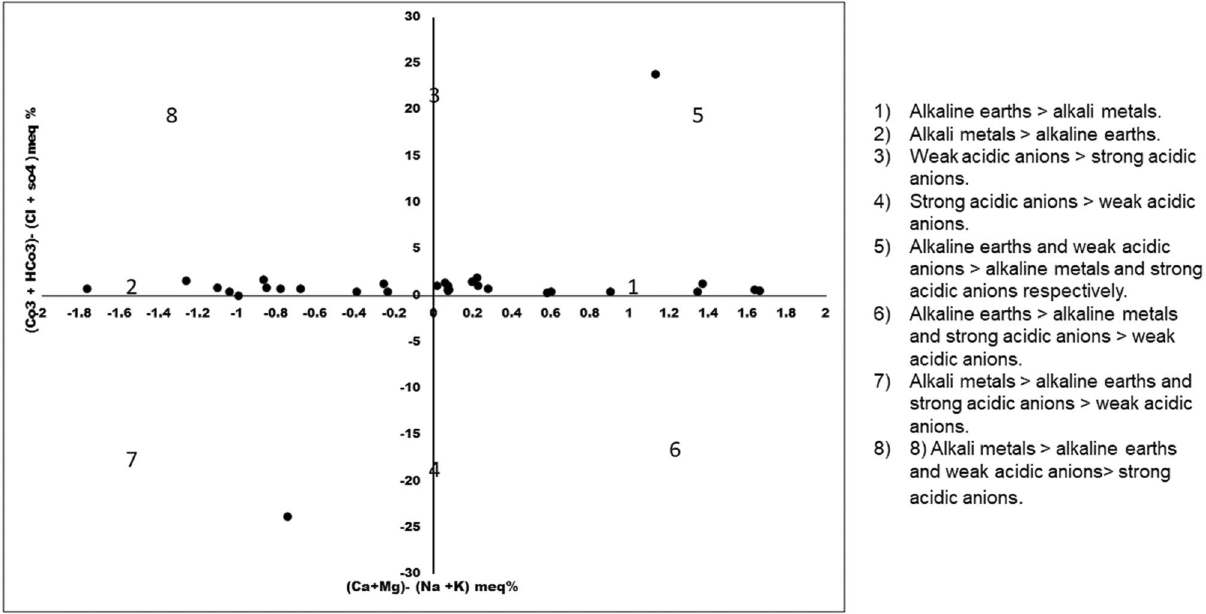
Figure 10. Chadha’s Plot for hydrogeochemical